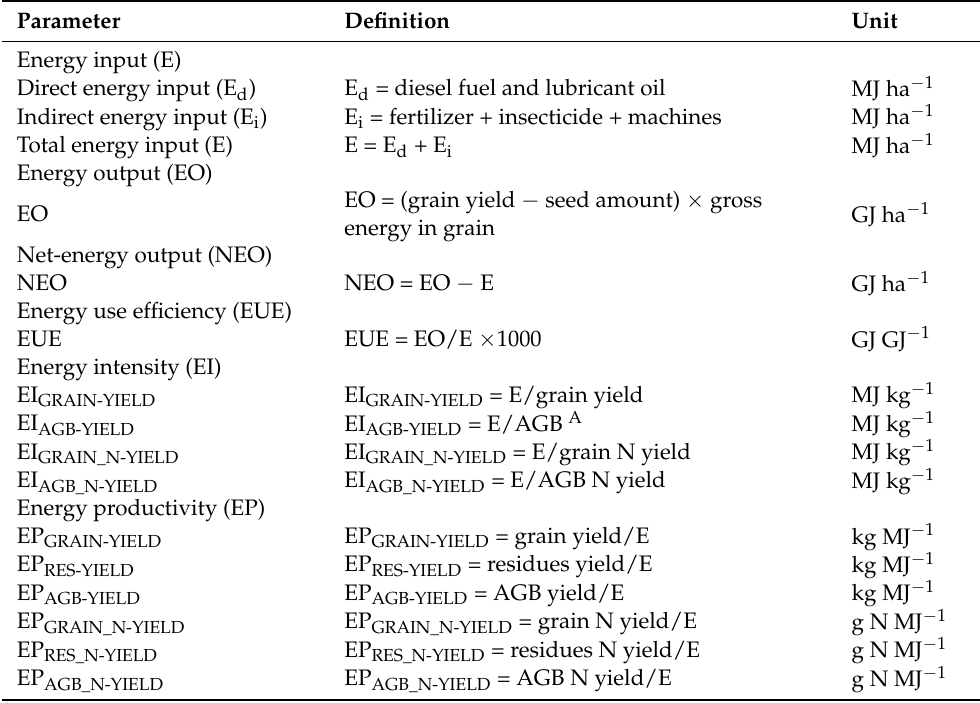
Table 2. Definition of energy efficiency